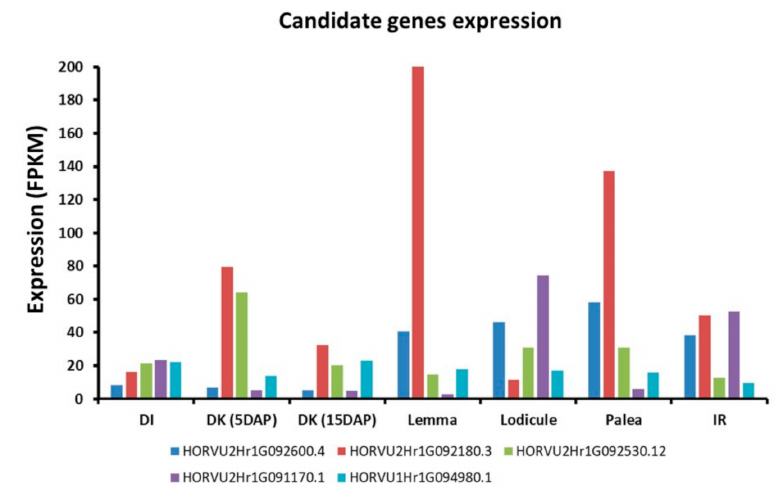
Figure 8. Expression analysis of the most important candidate genes: HORVU1Hr1G094980— early flowering 3 ( ELF3 ); HORVU2Hr1G092600— multiprotein bridging factor 1A ; HORVU2Hr1G092180— elongation factor G ; HORVU2Hr1G092530— aldehyde dehydrogenase family 3 member F1 ; HORVU2Hr1G091170— expansin B3 in the developing inflorescence tissues; DI—developing inflorescences (1–1.5 cm); DK (5 DAP)—developing kernels (5 DAP); DK (15 DAP)—developing kernels (15 DAP); IR—inflorescences rachis (35 DAP); FPKM—fragments per kilobase of exon model per million reads mapped.